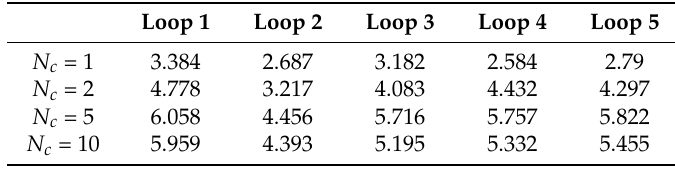
Table 5. Computing time in seconds with different control horizon sets.